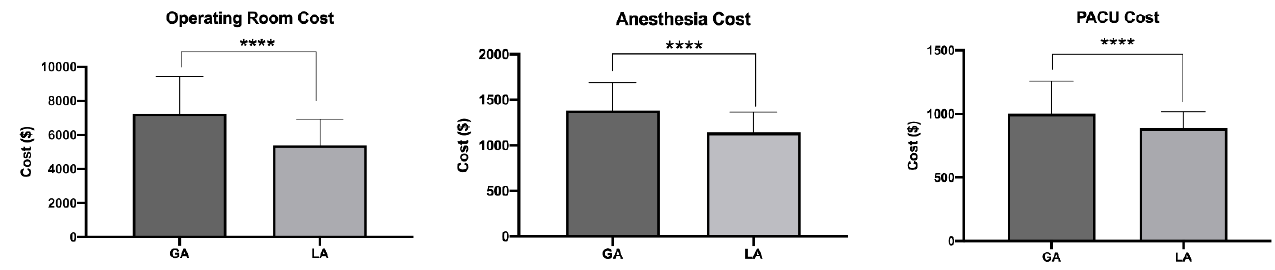
Figure 4. Costs for OR, anesthesia, and PACU between GA and LA groups, **** p <0.0001.